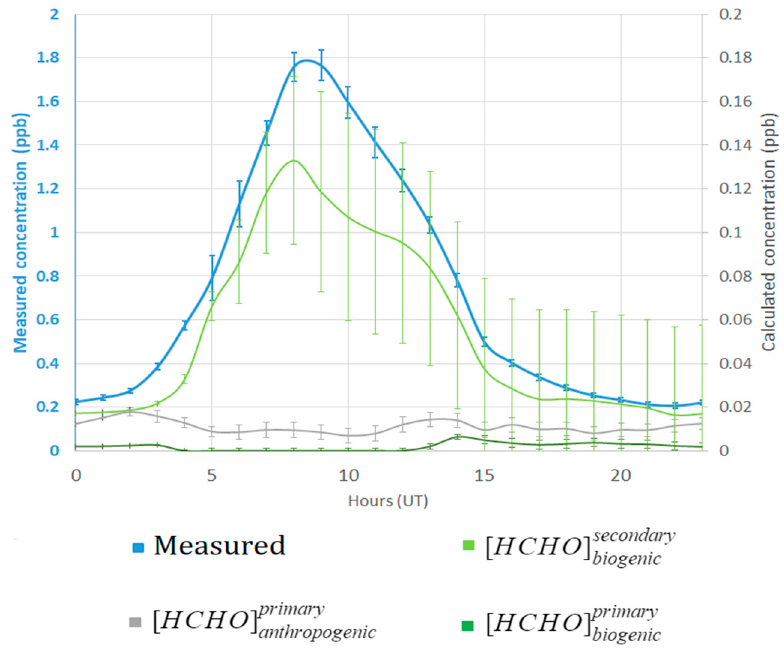
Figure 7. Measured formaldehyde mixing ratio at the Maïdo observatory and mixing ratio of the calculated known sources: primary/secondary biogenic and primary anthropogenic.